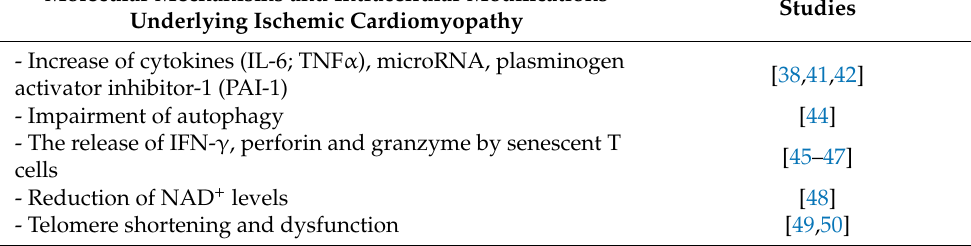
Table 1. Molecular mechanisms and intracellular modifications underlying ischemic cardiomyopathy (ICM). Molecular Mechanisms and Intracellular Modifications Underlying Ischemic Cardiomyopathy